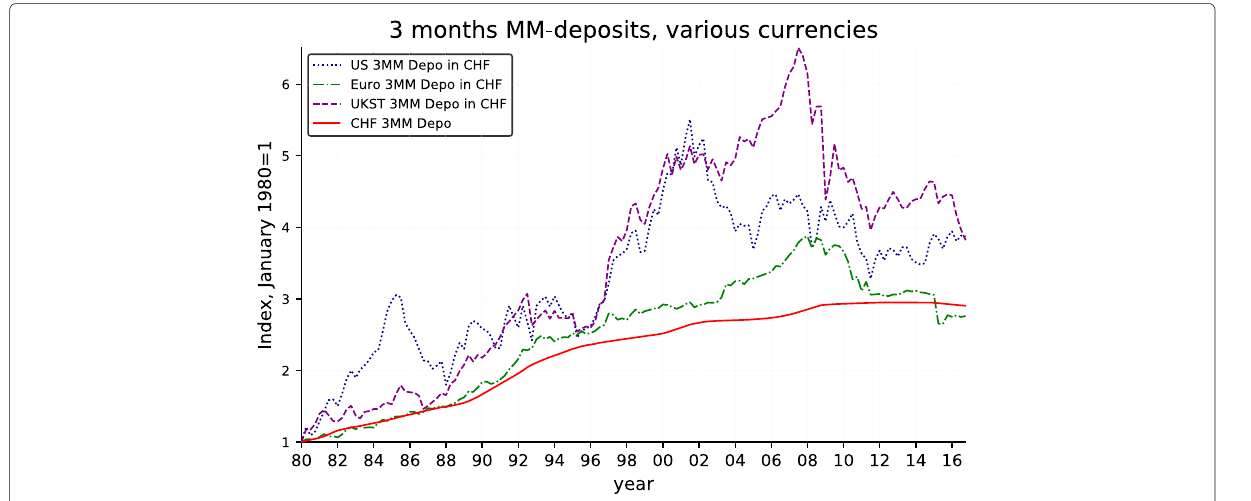
Fig. 3 Cumulative return on 3-month MM deposits after conversion into CHF